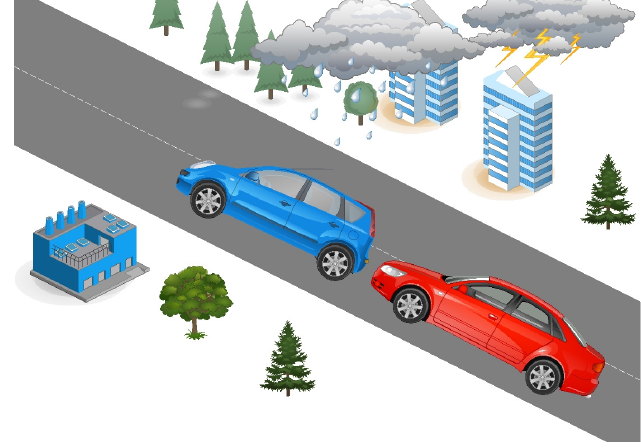
Figure 1. Vehicle tailgating. The red vehicle tailgates the blue one.